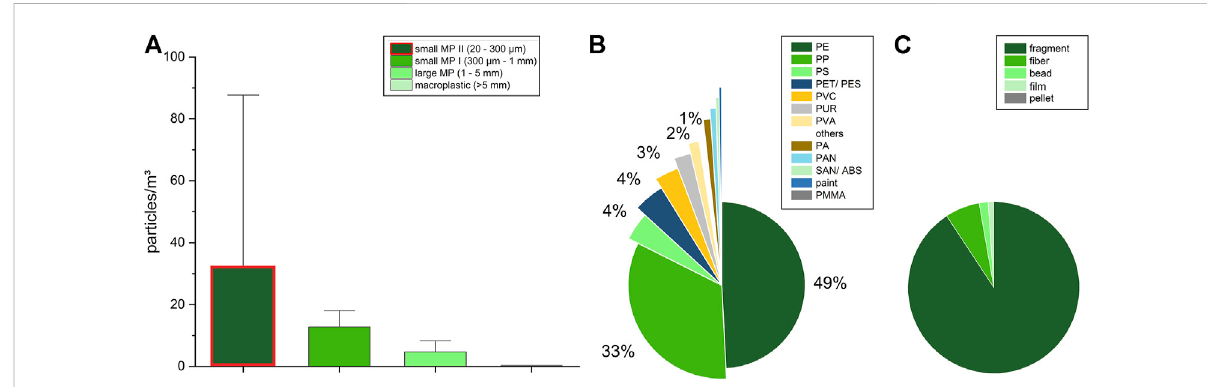
FIGURE 3 Size distribution and shares of polymer types and shapes of MPs in the whole sample set. (A) Particle concentration per size class. The non- quantitatively sampled size class small MP II (20 – 300 μ m) is marked with a red box to highlight the potential underestimation of particle abundance < 300 μ m. Percentage of (B) polymer type and (C) shape. Detailed information for each sample location is given in the Supplementary